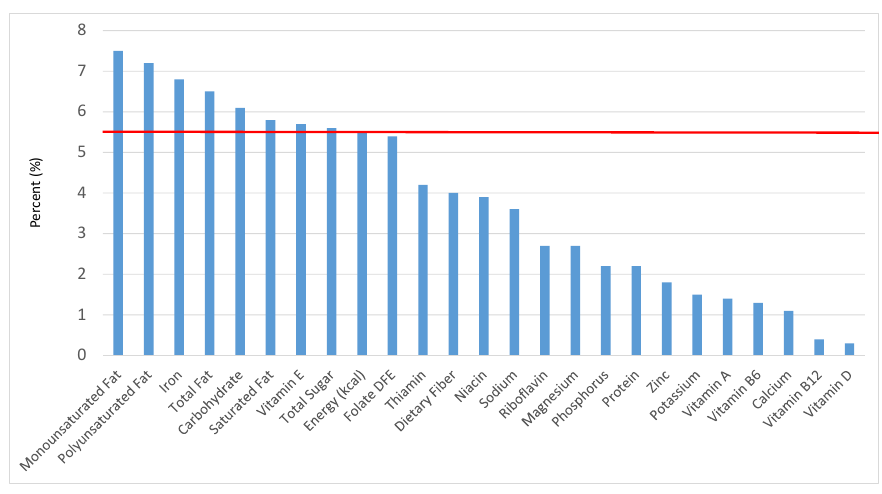
Figure 27. Sweet bakery products as sources of energy and nutrients for children 1–3 years old ( N = 1423, daily intake data): DFE = Dietary Folate Equivalents; solid red line represents percentage of energy (kcal) provided in the diet relative to nutrients—nutrients above the red line show the grain food’s contribution to nutrient density.